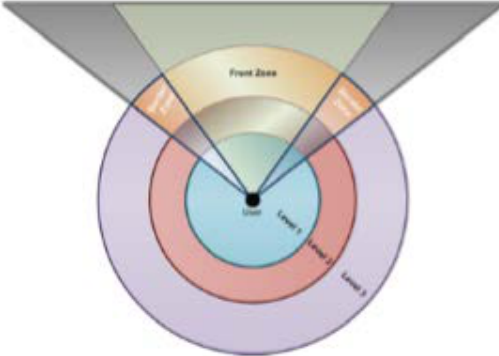
Figure 1. The headlights zoning and area of interest overlapping (Aljaafreh et. al, 2013) 3D model transport protocol (3TP) (Al-Regib and Altunbasak, 2003) uses transport control protocol (TCP) combined with user datagram protocol (UDP). This choice of protocol utilizations depends on three factors: (i) the 3-D models and the sizes